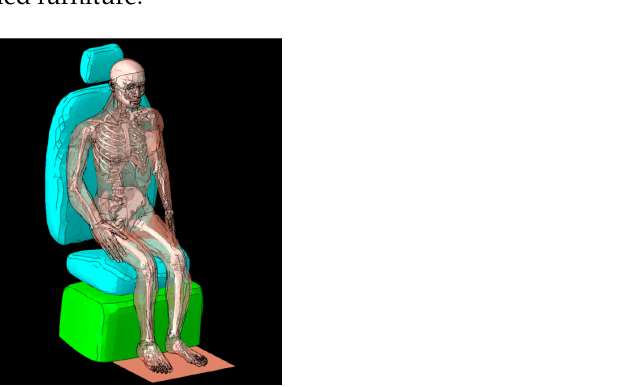
Figure 3. Full-body human FE model, including the bony structure, soft tissues, and skin [1].